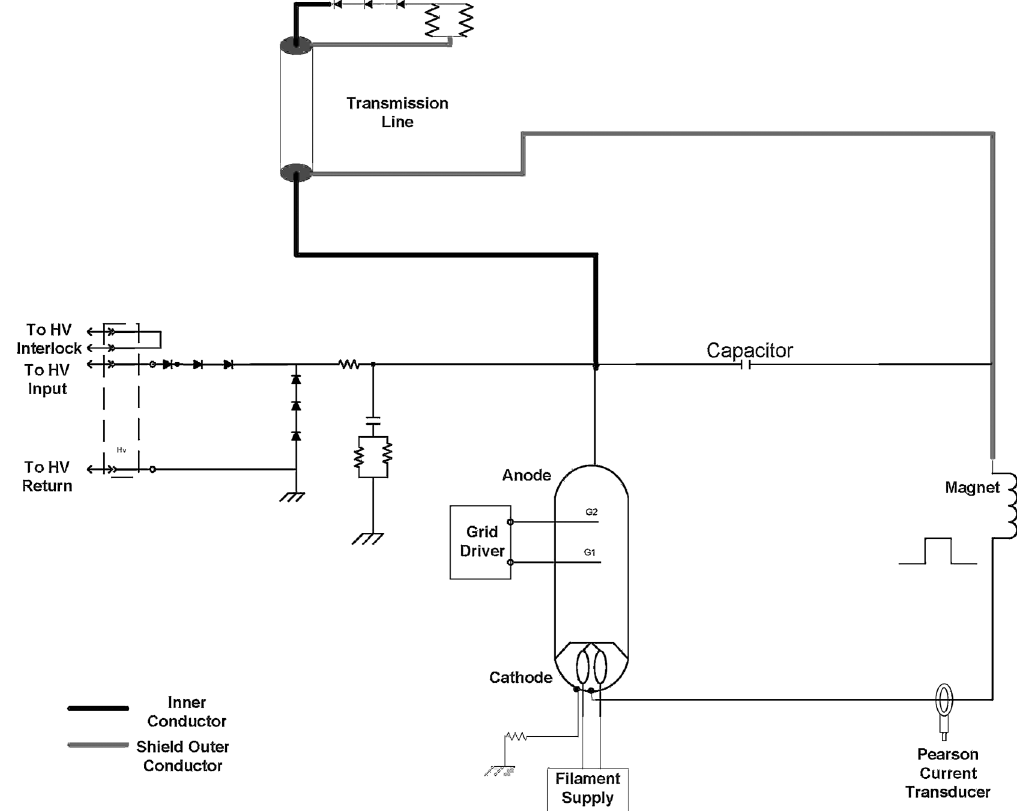
FIG. 9. Booster injection kicker driver block diagram.